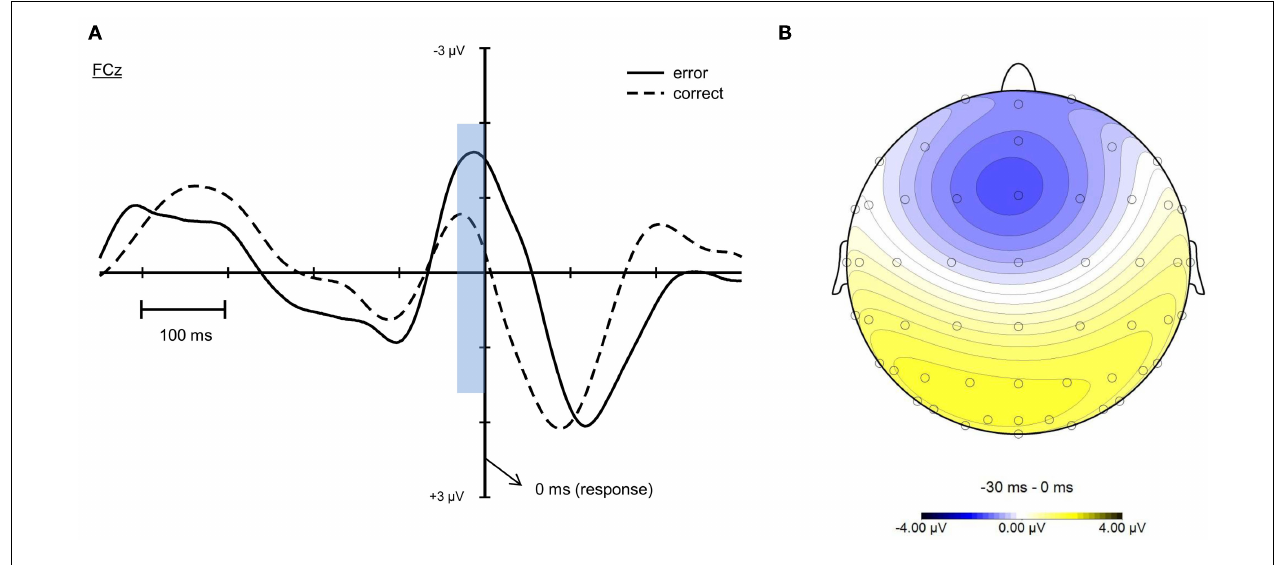
that already peaked prior to the given response. (B) shows a typical topography of the Ne with a fronto-central maximum in an interval from − 30 to